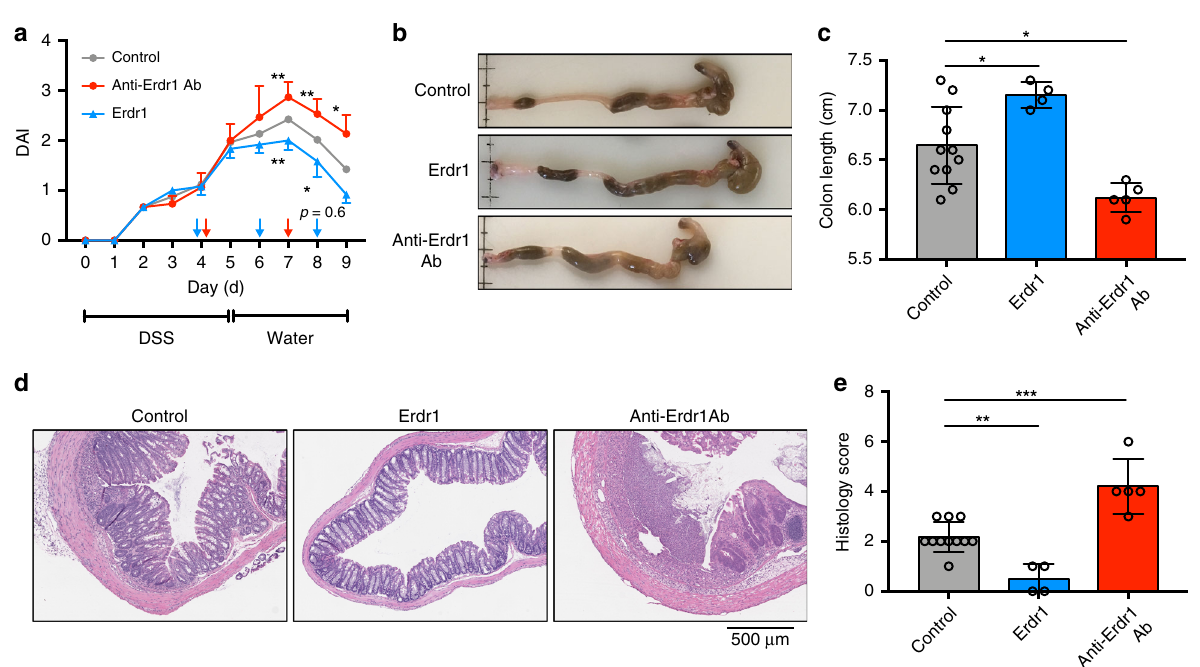
Fig. 8 Erdr1 promotes recovery from dextran sulfate sodium (DSS)-induced colitis. a DAI score of mice treated for 5 days with DSS, followed by normal drinking water for 4 days. Erdr1 was administered at day 4, 6, and 8; anti-Erdr1 antibody was administrated at day 4 and day 7. b Colon images from mice treated in a . c Colon length from mice treated in a . d Representative H&E stained sections and e histology scores from mice as treated in a . n = 11 (control), n = 4 (Erdr1), n = 5 (anti-Erdr1 Ab); representative of two experiments. All data are presented as mean ± SD; * P < 0.05, ** P < 0.01, by one-way ANOVA with Tukey ’ s multiple comparison